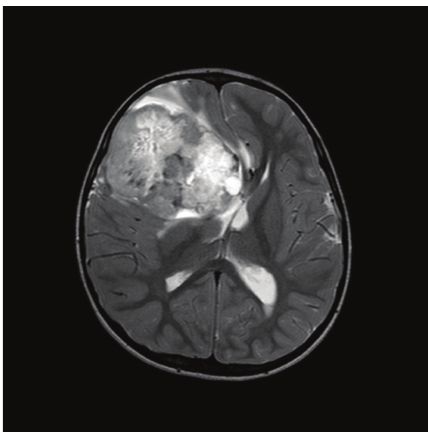
Figure 13: MRI brain: large right frontal lobe mass.